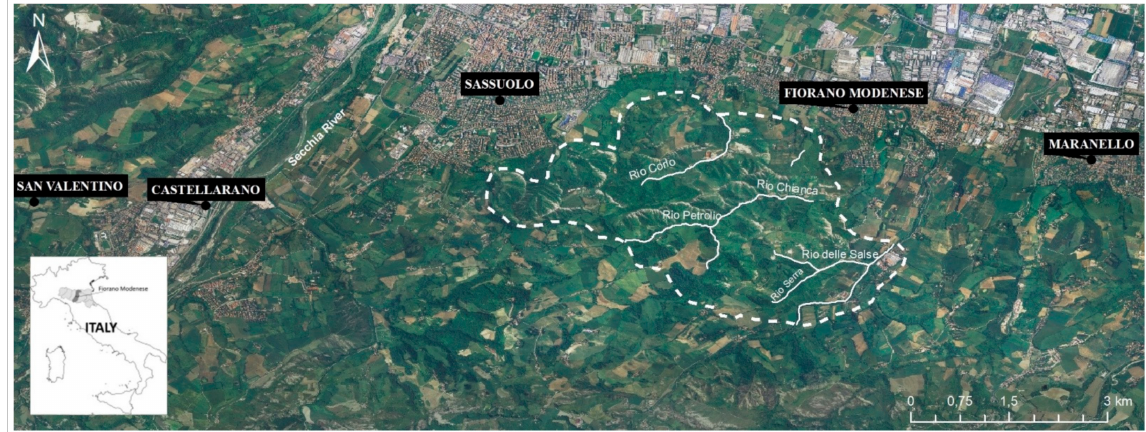
Figure 1. Location of the study area (white dashed line) and localities cited in this paper (©2017